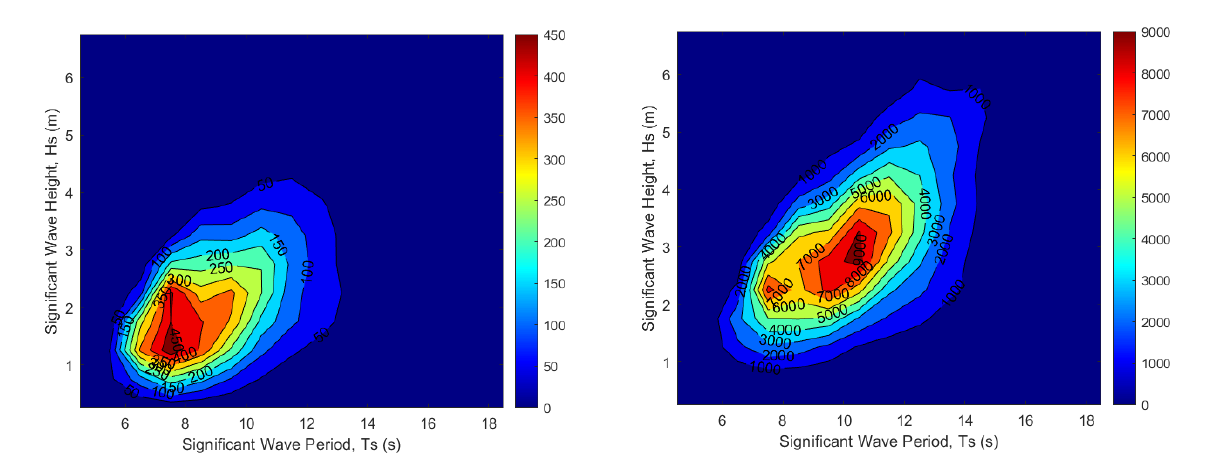
Fig. 5: Total hours per year of different sea states from (left), and total available energy resource for each sea state in kWh per meter of wave crest per year (right). Data from Humboldt Bay, CA [18].